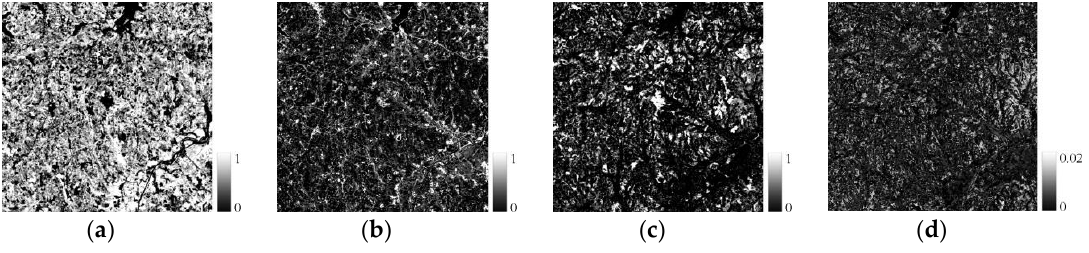
Figure 11. Fraction and error (study area 3). ( a ) Vegetation, ( b ) Impervious surface, ( c ) Bare soil, ( d ) RMSE.